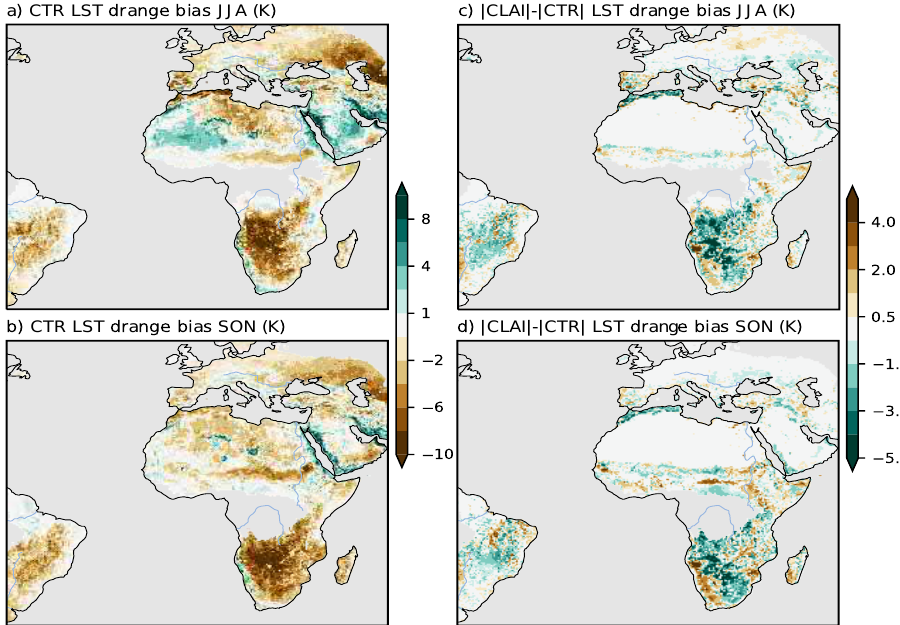
Figure 9. Mean diurnal range (drange) bias of Land Surface Temperature (LST) in the control simulation (CTR) during June-August (JJA, ( a )) and September-November (SON, ( b )). Difference of the mean absolute bias in the simulation with new ESA-CCI LU/LA map and LAI disagragation (CLAI) in respect to the control simulation for JJA ( c ) and SON ( d ). Note that the color bar for differences in ( c , d ) has a range that is only half of the range in ( a , b ). The statistics were computed for the period 2004 to 2015 considering only clear-sky